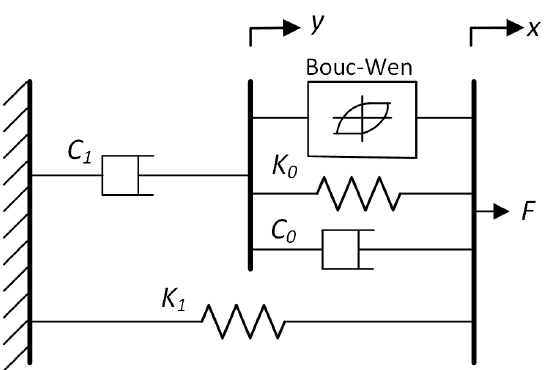
Figure 3. Lumped elements equivalent model for a magneto–rheological